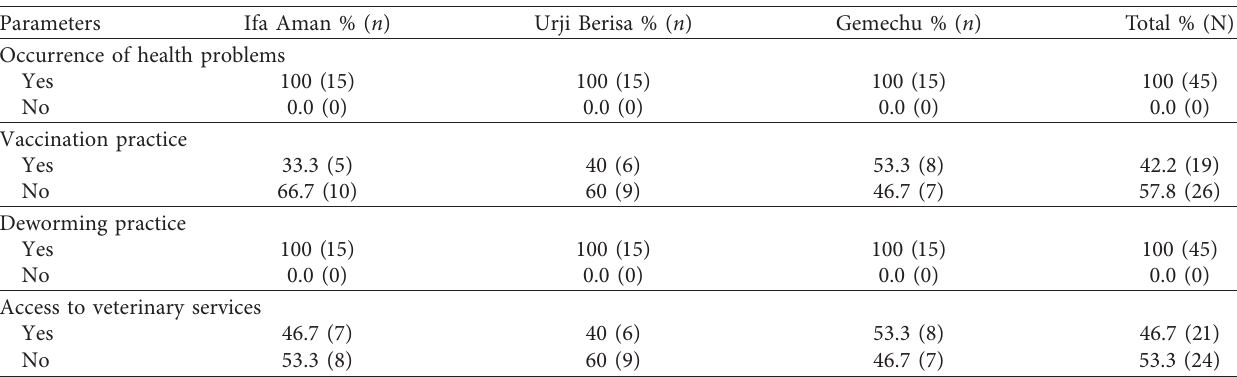
Table 2: Occurrence of diseases and producers’ access to animal health protection facilities in the selected three kebeles of Doba district. Parameters